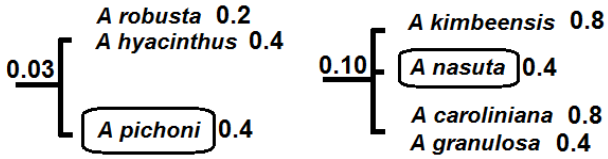
Figure 4. Two subsets of the larger phylogenetic tree (Figure 2). Two species that are currently near-threatened, A. nasuta and A. pichoni , are competing for conservation priority. Numbers indicate probabilities of extinction, with probability for a deeper branch equal to product of probabilities of descendants. A. pichoni has relatively secure sister species, while A. nasuta does not. Priority for A. nasuta would imply greater gain in expected